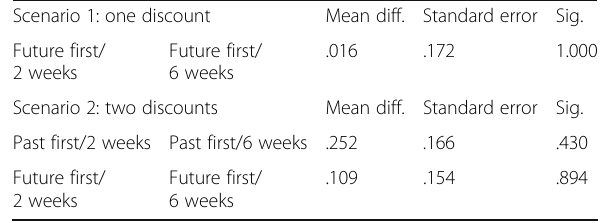
Table 5 Regret scores for first and second